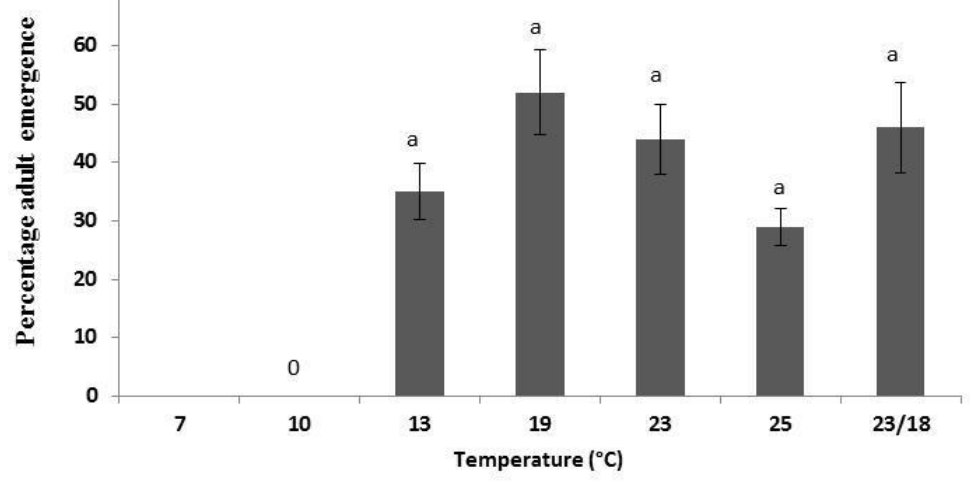
Figure 3. Percentage emergence of Tuta absoluta adults at various temperatures. Different letters denotes significant differences ( p < 0.05).